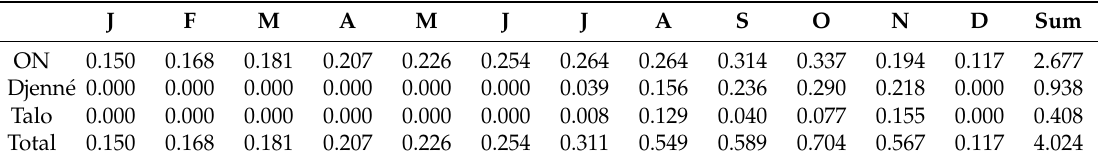
Table 2. Average monthly amount of water abstraction (km 3 /month) over the Niger Inland Delta for irrigation (Where ON is “Office du Niger” irrigation schemes, Djenn é & Talo are reservoirs for the ORM’s (“Office-Riz-Mopti”) irrigation schemes).